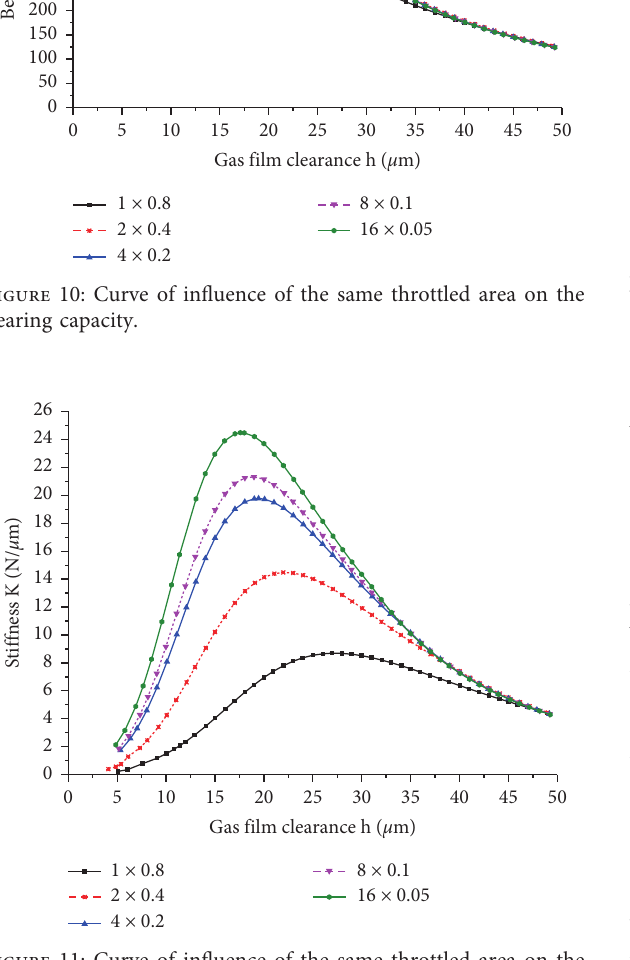
Figure 11: Curve of influence of the same throttled area on the bearing